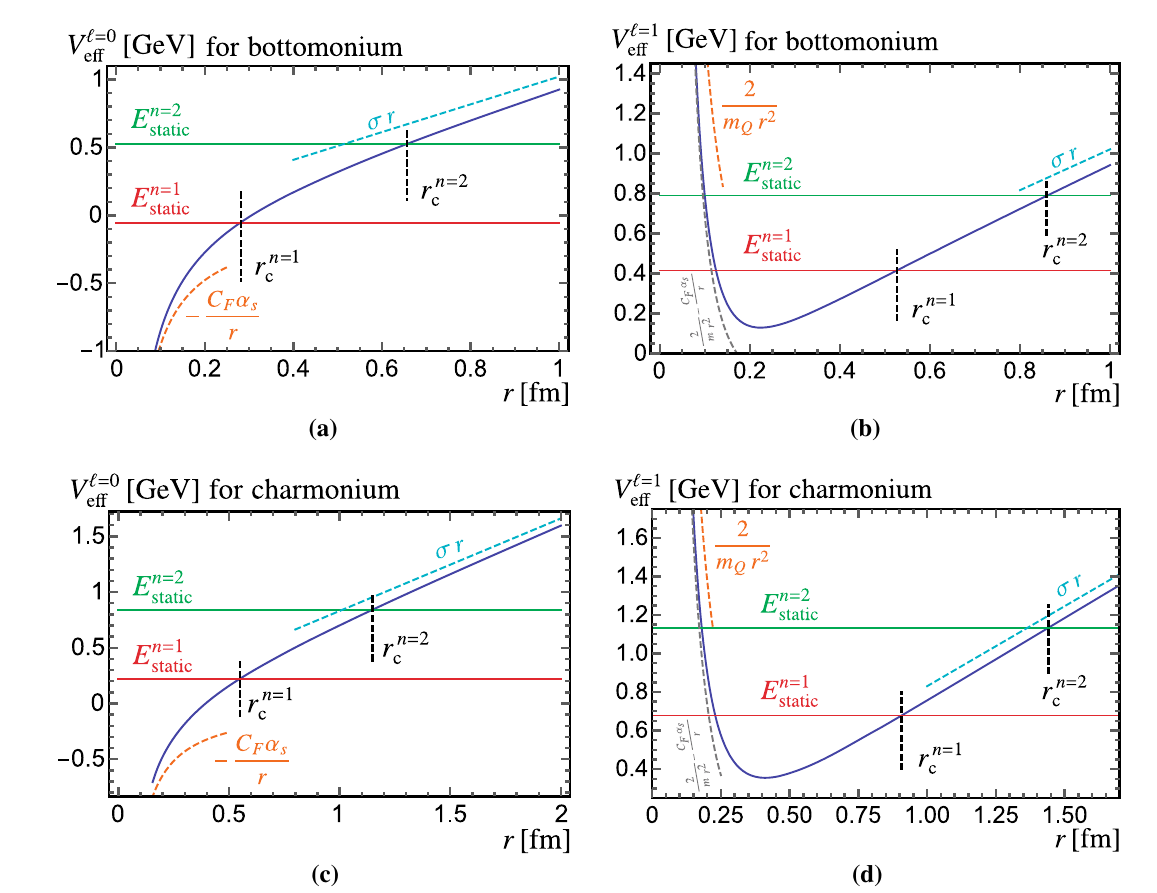
Fig. 1 Effective static Cornell potential for (cid:6) = 0 (left panels) and (cid:6) = 1 (right panels), for bottom (upper panels) and charm (lower pan- els), as defined in Eq. (5). The first two energy eigenvalues are shown as horizontal lines in red (ground state) and green (first excited state). The corresponding classical radius for these energies are signaled with